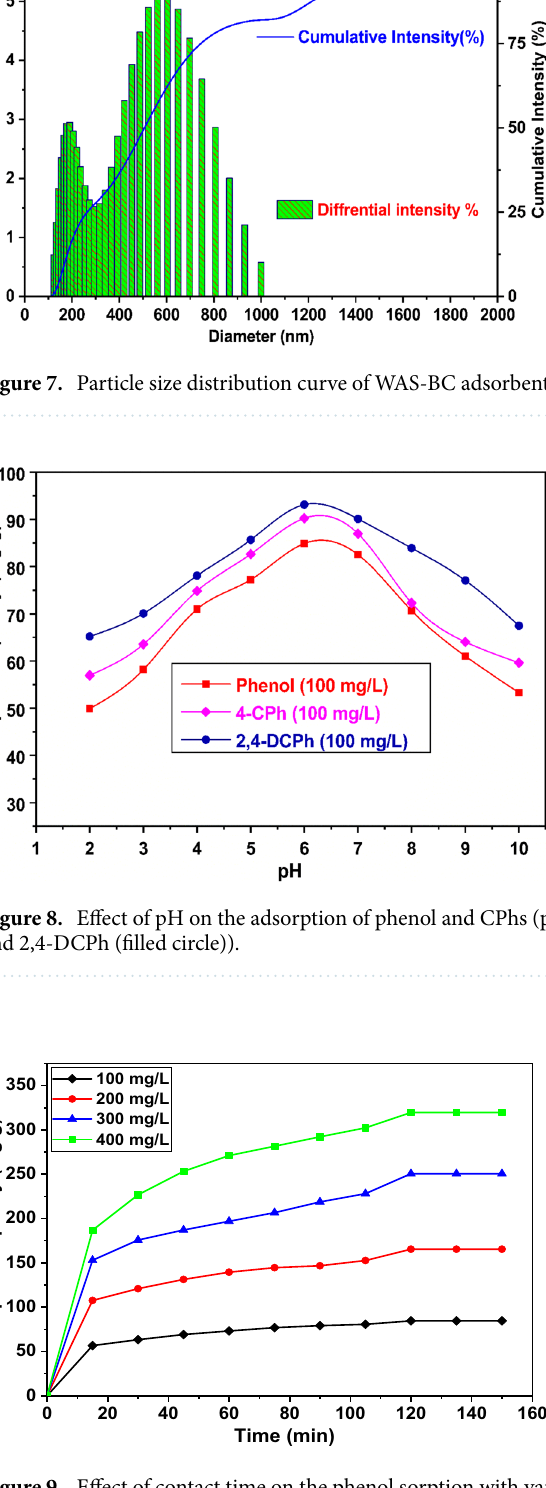
Figure 9. Effect of contact time on the phenol sorption with various initial concentrations, C 0 = 100 mg/L (filled diamond), 200 mg/L (filled circle), 300 mg/L, (filled triangle) 400 mg/L (filled